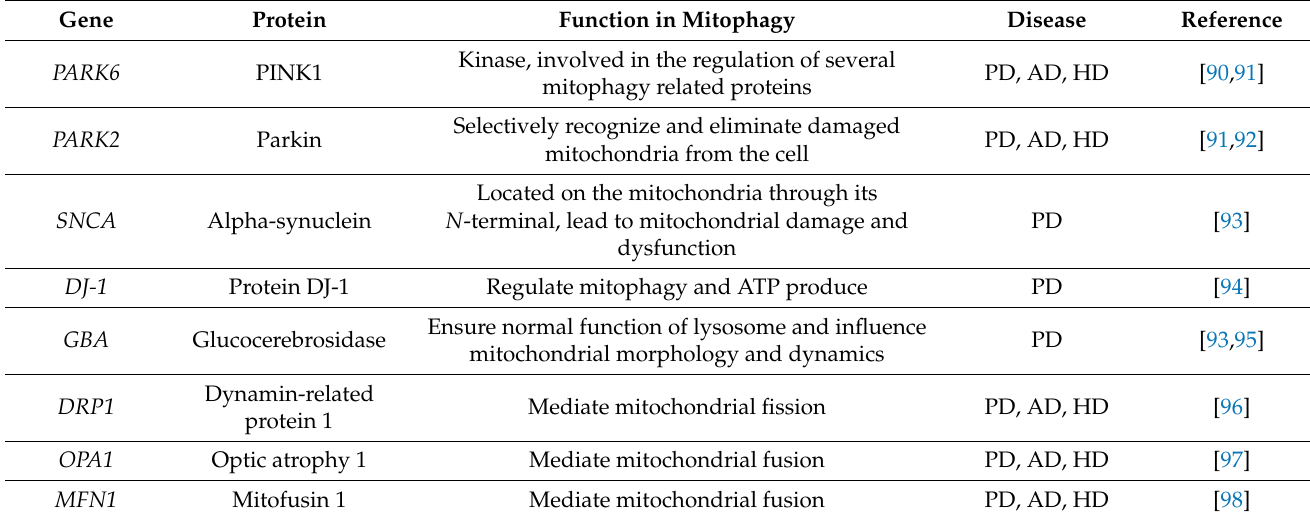
Table 1. Genes related to neurodegenerative diseases and